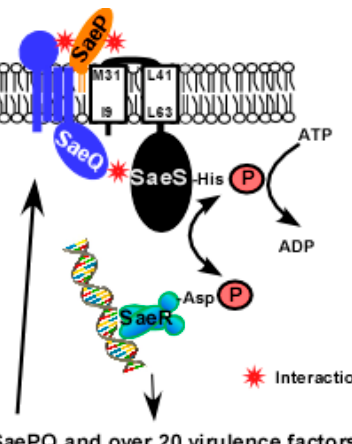
Figure 4. A model for SaePQS interaction. Upon exposure to the inducing signal(s), SaeS autophosphorylates the conserved His residue with ATP; then the phosphoryl group is transferred to the conserved Asp residue of SaeR. The phosphorylated SaeR binds to its binding sequence and activates transcription from target promoters including the sae P1 promoter. From sae P1, SaeP and SaeQ are produced and bind to SaeS in the membrane. As a lipoprotein, SaeP is expected to interact with the extracellular linker peptide of SaeS. On the other hand, SaeQ is thought to interact with the cytoplasmic domain of SaeS [22]. The interacting parts of SaePQS are based on predictions.